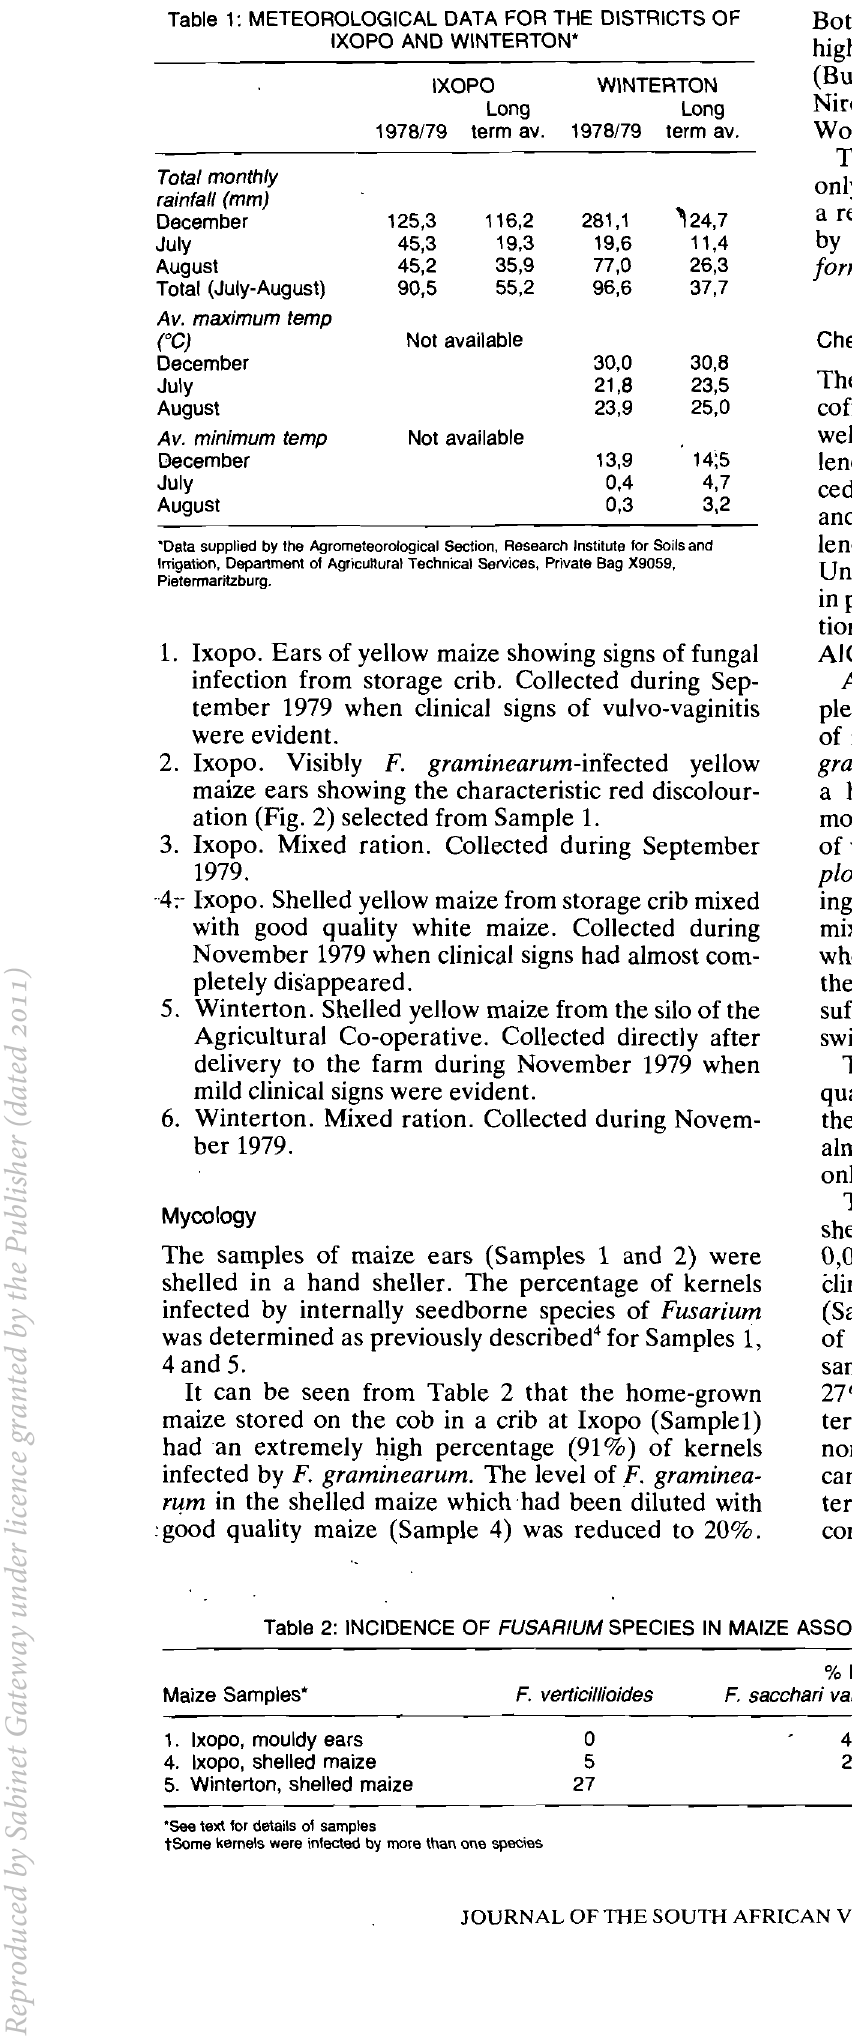
Total monthly rainfall (mm)